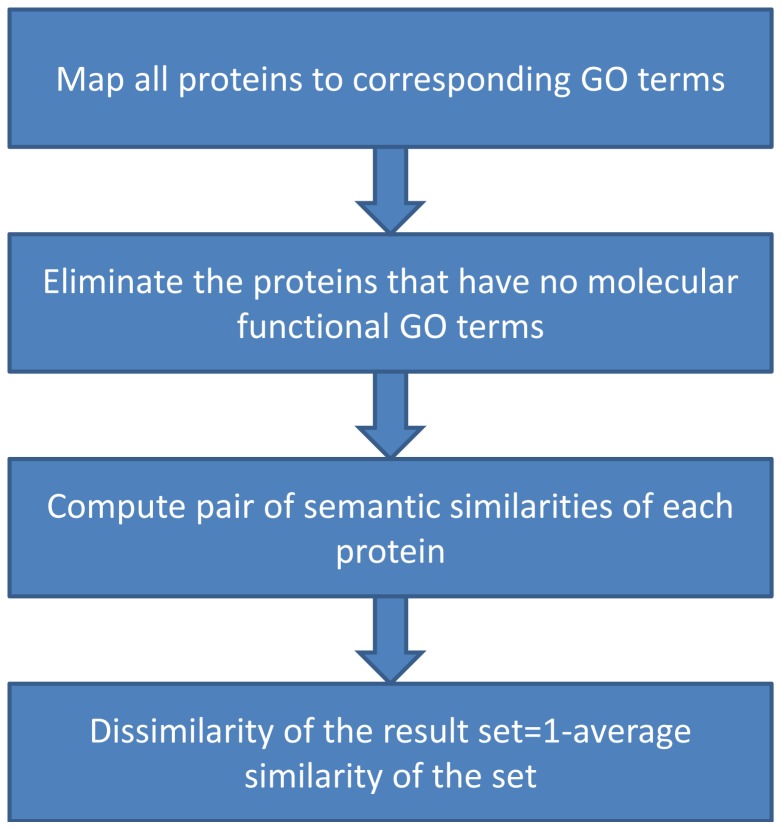
The steps for finding the functional diversity of a set of protein sequences.